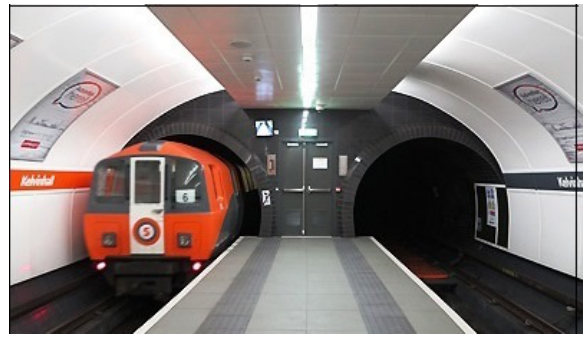
Figure 9. Current Glasgow subway – Kelvinhall station